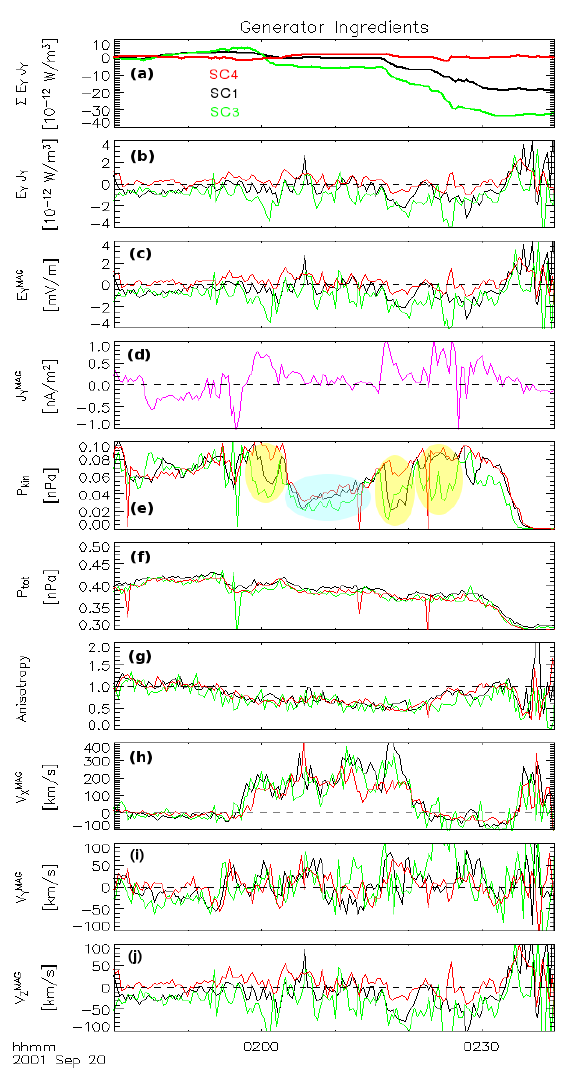
Fig. 13. Cumulative sum of E Y J Y (a) , E Y J Y (b) , E Y (c) , J Y (d) , kinetic (e) and total (f) pressure, anisotropy (g) , and the velocity components (h–j) . All the quantities are shown for SC1 (black), SC3 (green), and SC4 (red), except for the current, which is derived by the Curlometer and representative for the whole tetrahedron. The plasma moments are derived from CODIF data. The yellow shading in panel (e) emphasizes the intervals with substantial P kin gradients, while the cyan shading indicates the time in between, when SC1, SC3, and SC4 measure about the same P kin